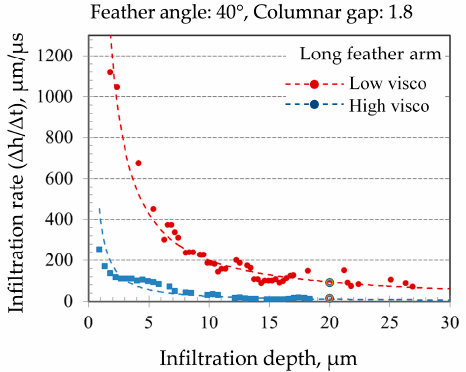
Figure 18. Decrease in the infiltration rate with respect to the infiltration depth measured in columnar gaps based on low and high viscosity values for 40° feather inclination, 1.8 µm columnar gap and long feather arm condition.